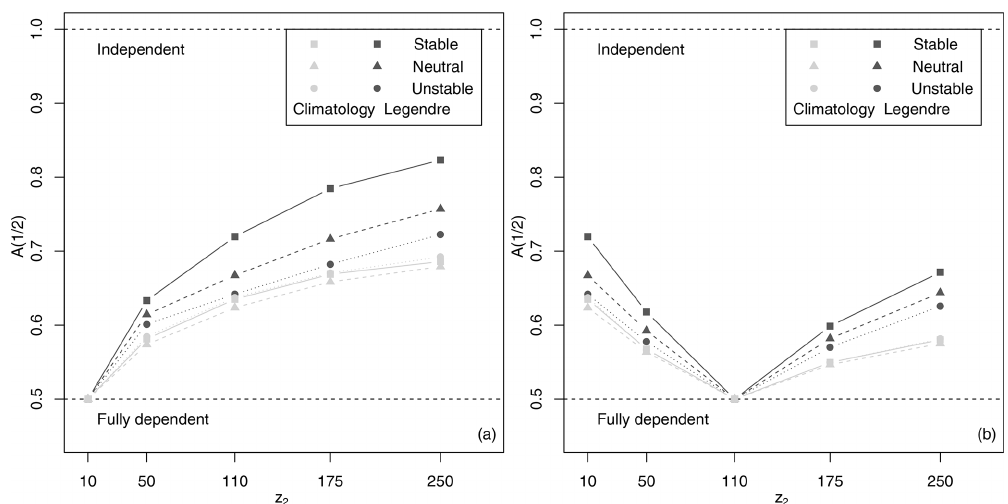
Figure 12. Pickands dependence function at ω = 1 / 2 between gusts (grey) and residuals (black) at all layers as well as (a) z 1 = 10m and (b) z 1 = 110m for stable, neutral, and unstable case, as in Fig. 11.